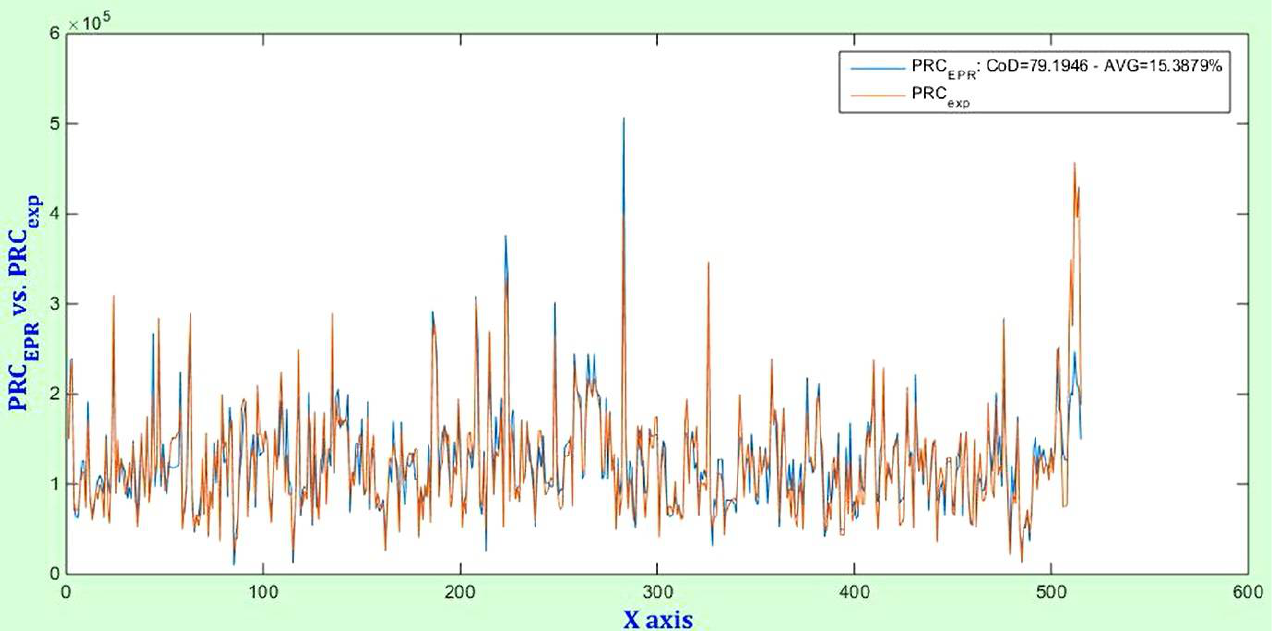
Figure 3. Selling price determined by EPR-MOGA (PRC EPR ) vs. selling price expected for model III (PRC exp ).